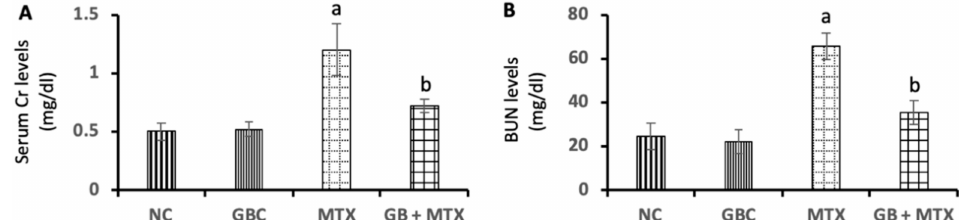
Figure 1. E ff ect of 20 mg / kg methotrexate (MTX, ip) only and when combined with 60 mg / kg Ginkgo biloba extract (GB, orally for 10 days) on the serum creatinine (Cr)( A ), and blood urea nitrogen (BUN) ( B ) levels in all studied groups. a p < 0.05 versus NC group. b p < 0.05 versus MTX